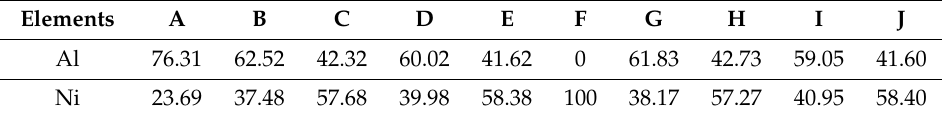
Table 3. Chemical composition (at %) of different points, as marked in Figure 3b–e.